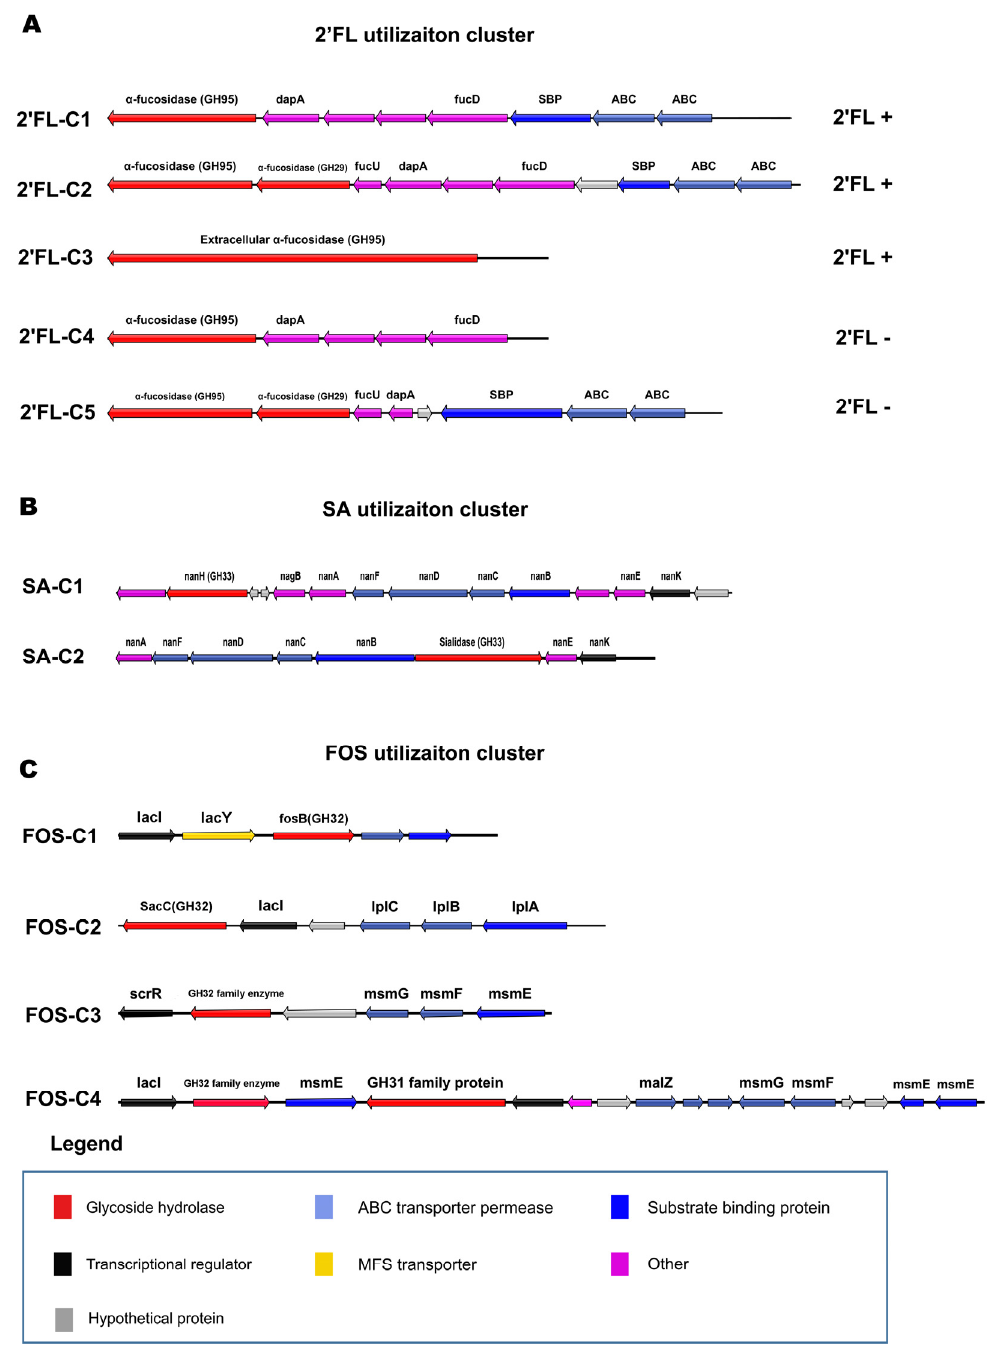
Figure 5. Locus map representing predicted carbohydrate utilization clusters. ( A ) 2’FL utilization clusters. ( B ) SA utilization clusters. ( C ) FOS utilization clusters.